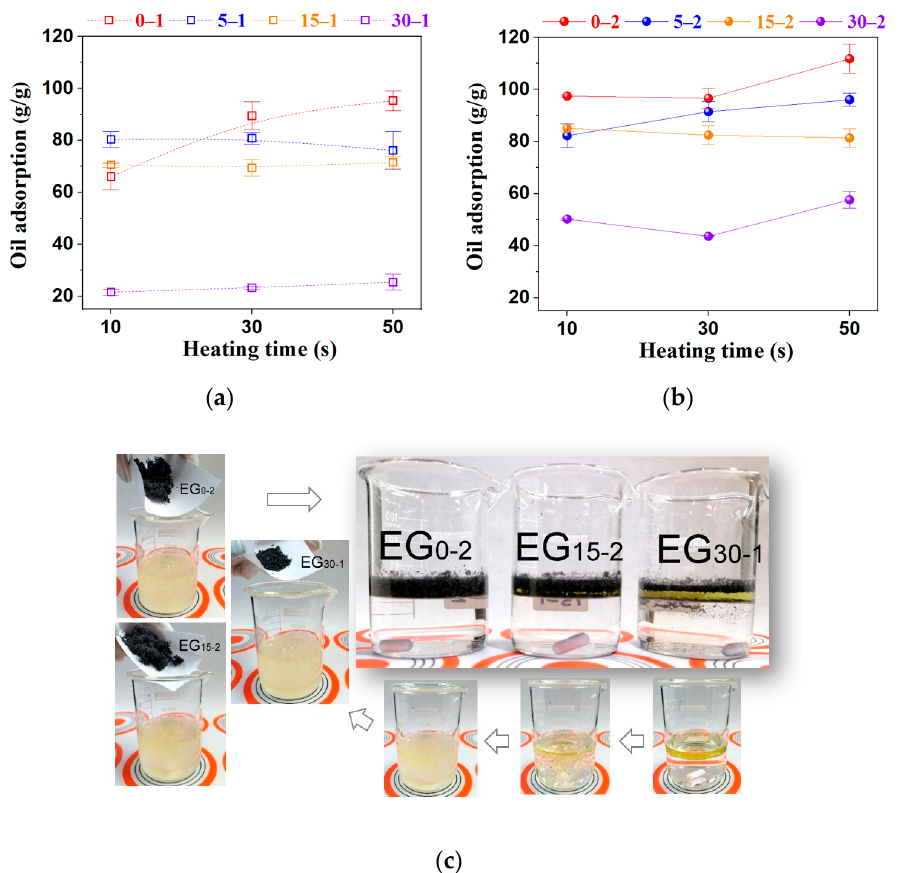
Figure 10. Graph of adsorption capacity as a function of the microwave heating time ( a , b ) and im- ages of oil adsorption testing ( c ), EGs (50 mg) were added to a stirred diesel–water mixture to show EGs high oil selectivity; central photos are the samples after resting.